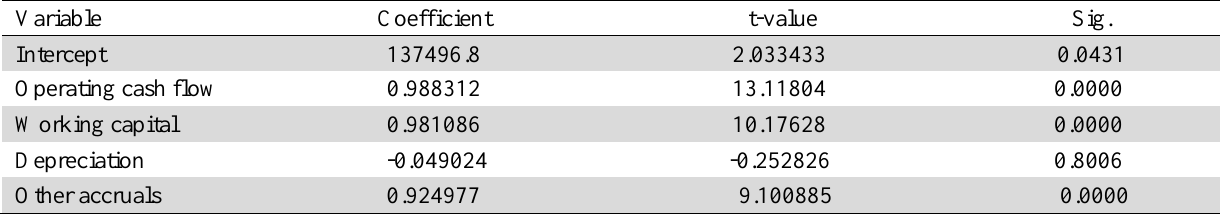
The summary of regression analysis for testing the second hypothesis